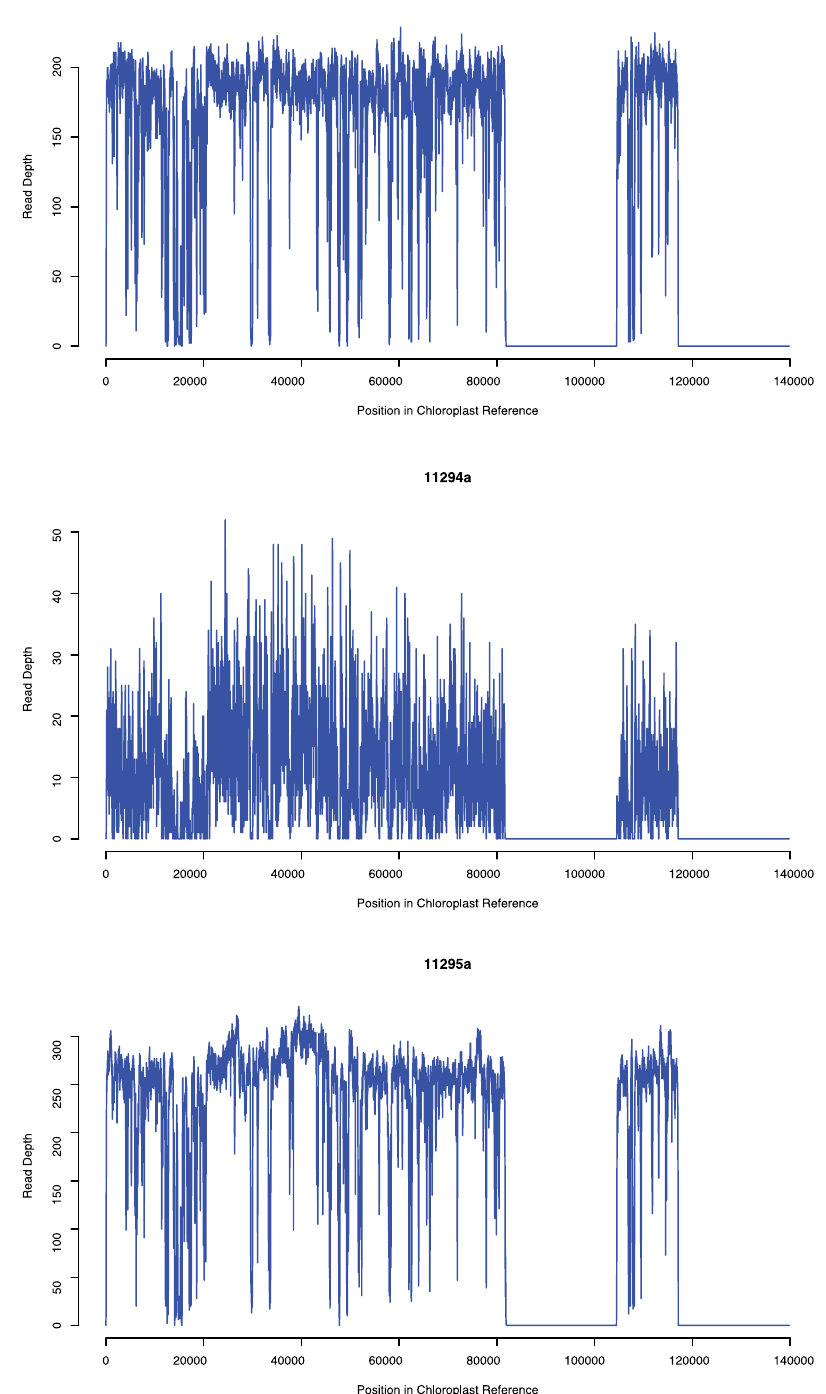
Figure 3. Read depth of mapped cpDNA. Read depth of cpDNA enriched libraries from the three Areni-1 millet grains mapped to the chloroplast reference genome: Genbank# KU343177.1. The IRs are shown in the large tracks of the graph which lack mapped